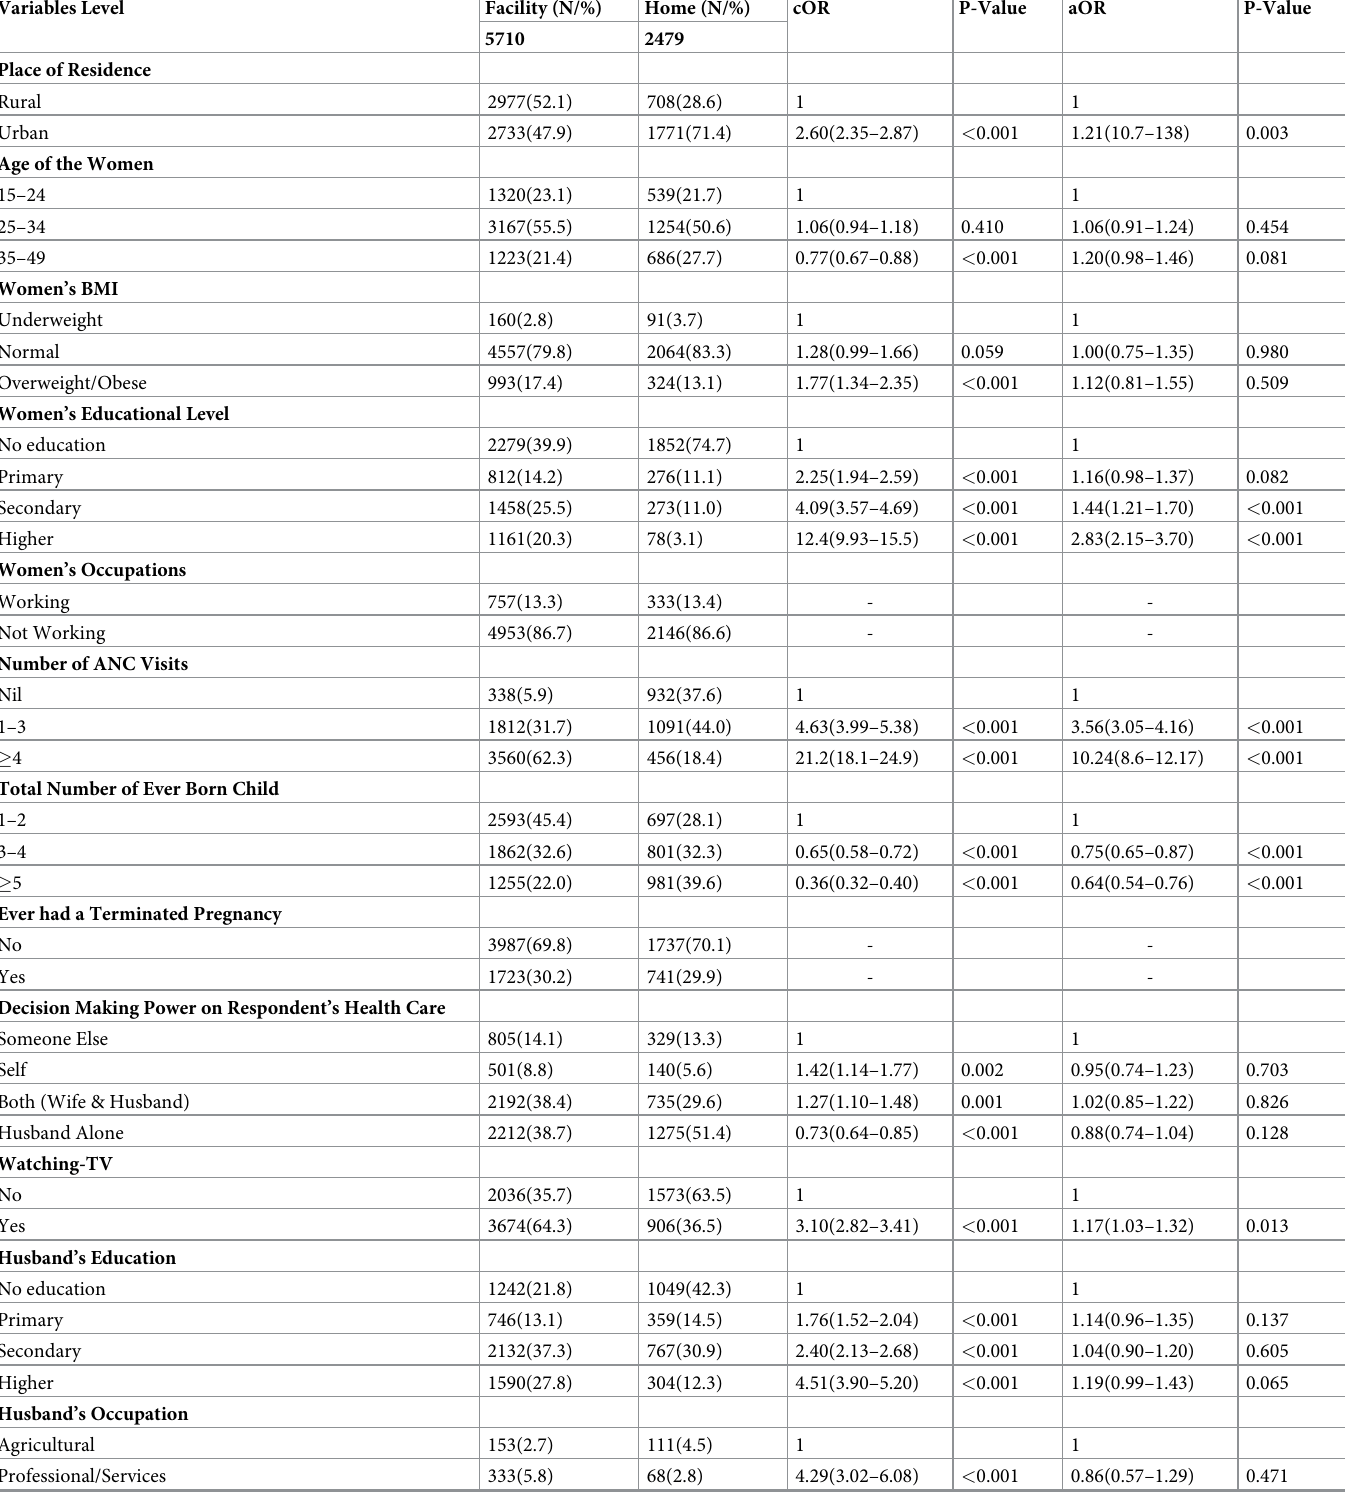
Table 5. Regression results factors associated with health facility delivery by background characteristics: PDHS